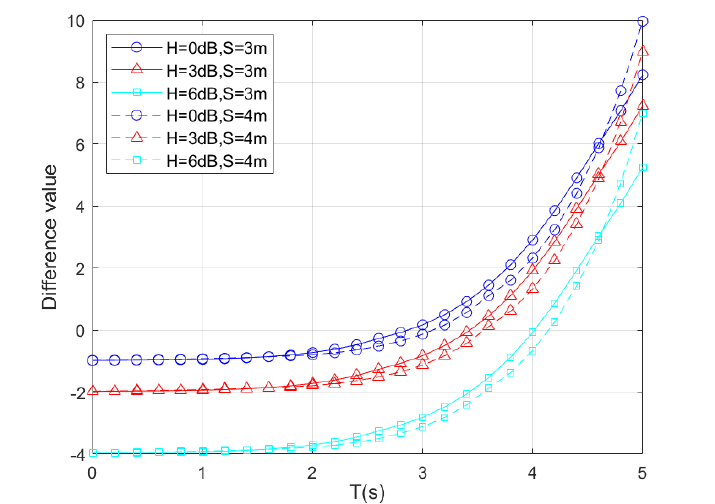
Figure 10. Influence of hysteresis margin on handover at different LED